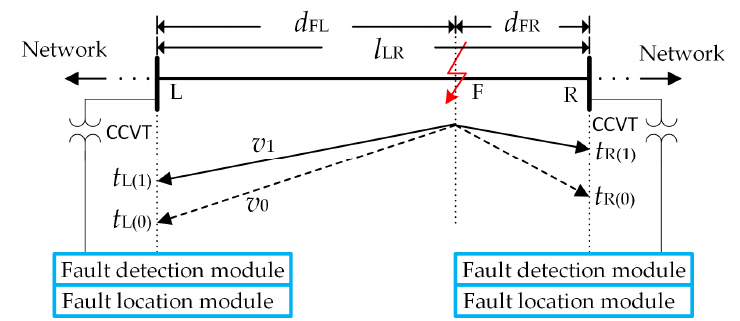
Figure 2. Time-space diagram for a line monitored at two terminals. CCVT—coupling capacitor voltage transformers.